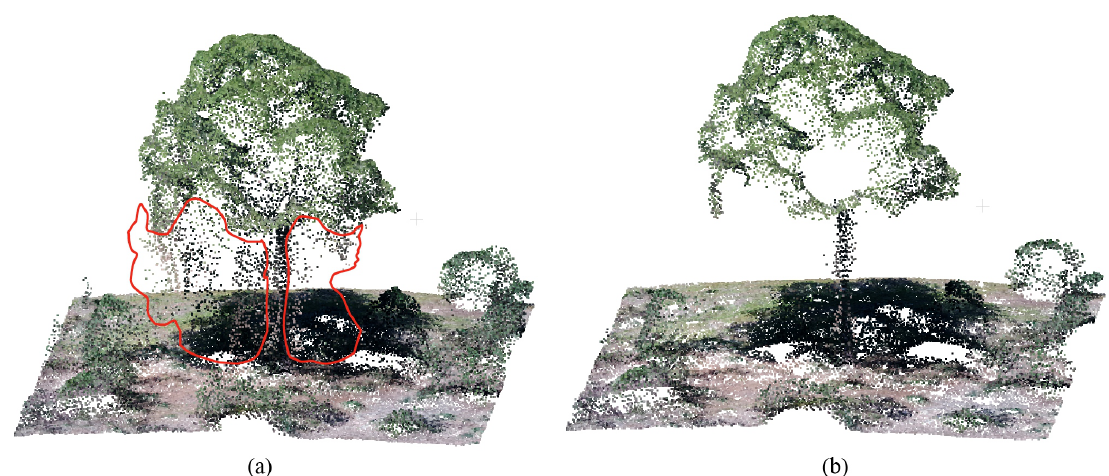
Figure 4. The point-based filter of a cutout of the point cloud. ( a ) The original dense point cloud; and ( b ) The filtered point